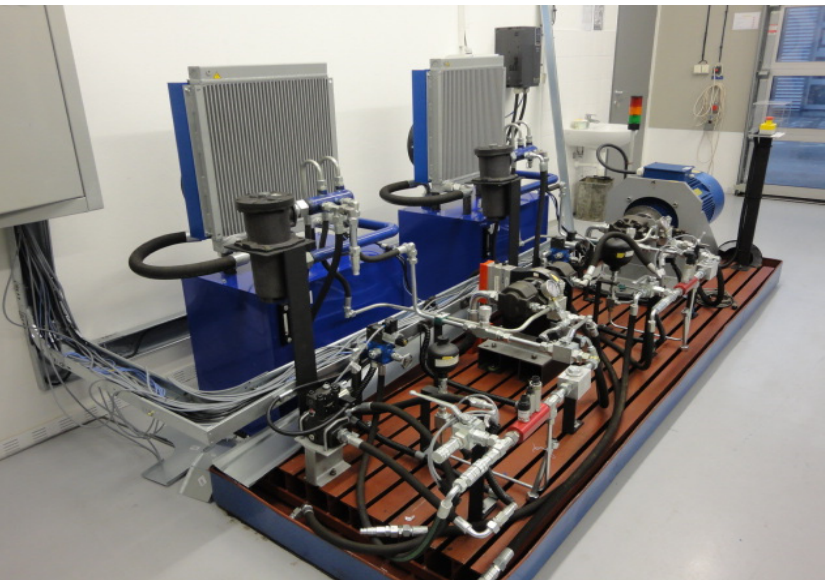
Figure 5. A view of the implemented test equipment.